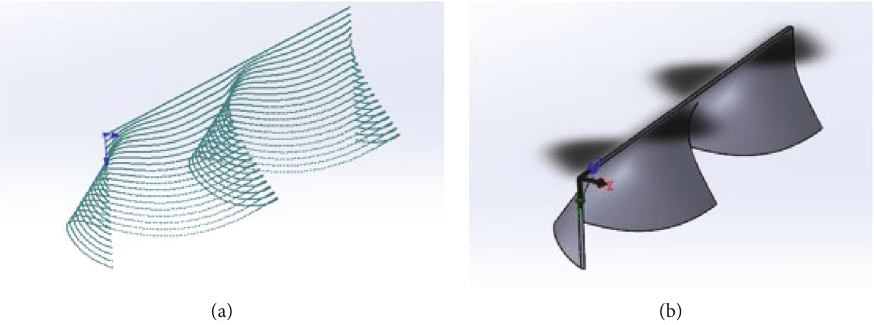
Figure 3: (a) Point cloud import to Solidworks. (b) Generated physical model of the dorsal fi